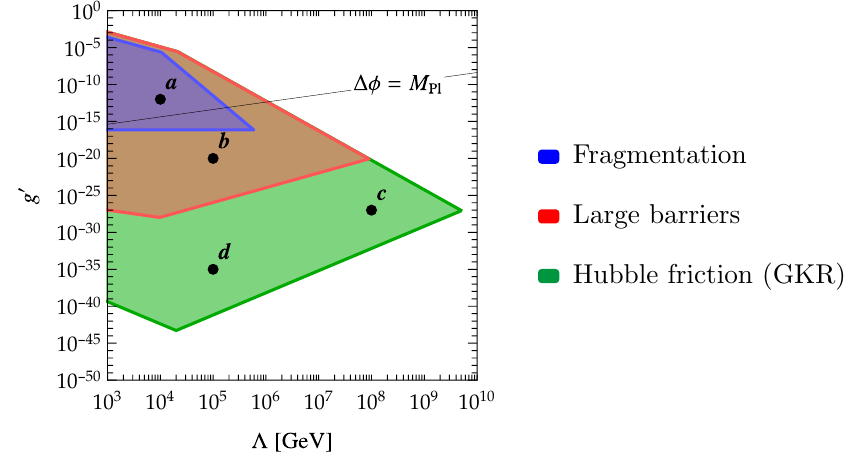
Figure 2 . Parameter space projected in the (cid:3) ; g 0 plane of the relaxion mechanism taking place with Higgs-dependent barriers, during in(cid:13)ation, where the relaxion is a subdominant component of the energy density of the universe (non-QCD case of [1]), as described in section 3.1. Shown are three distinct stopping mechanisms. ‘Hubble friction’ corresponds to the mechanism discussed in [1].